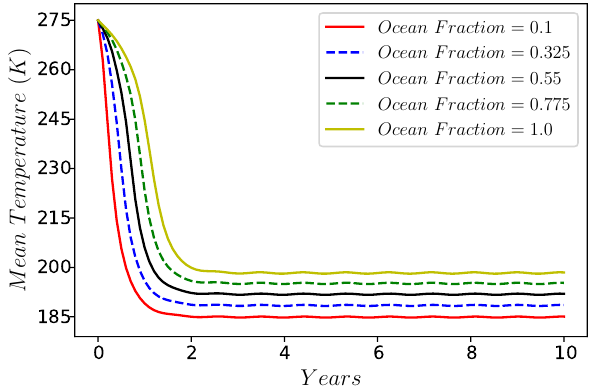
Figure 8. Simulation for a Sun-Earth system with different ocean fraction which compares the required time to reach a semi-stable condition.